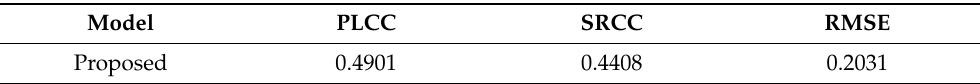
Table 4. The proposed method is trained on the IRCCyN/IVC database, and the performance of our proposed method is tested on the IETR database.